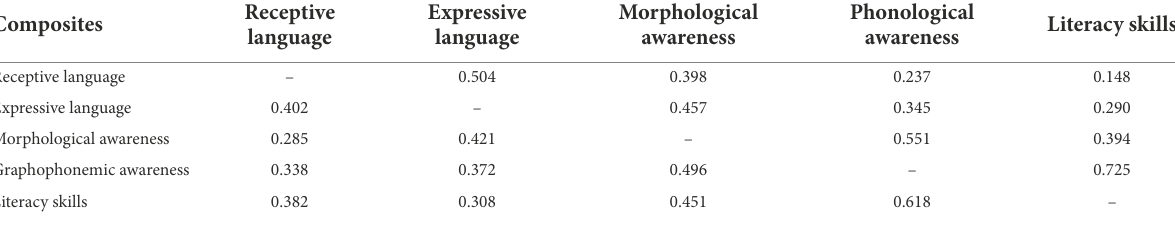
TABLE 3 Inter-correlations among composite scores (Time 1 and Time 2).